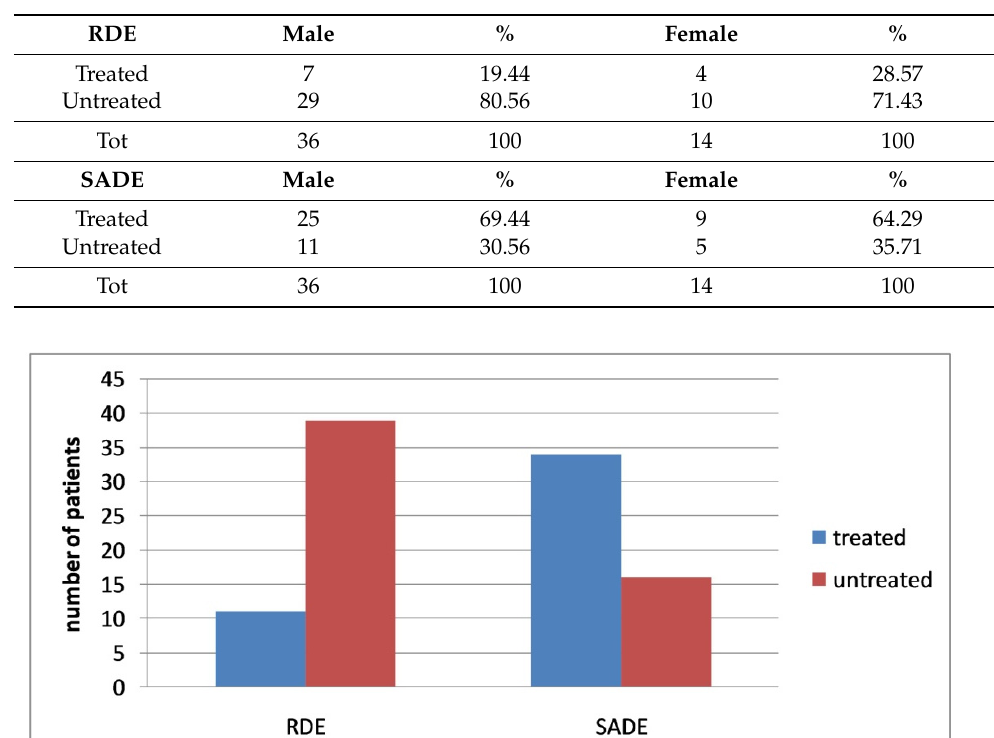
Table 1. Difference by sex in treatment success in regular dental environment (RDE) and in sensory- adapted dental environment (SADE).